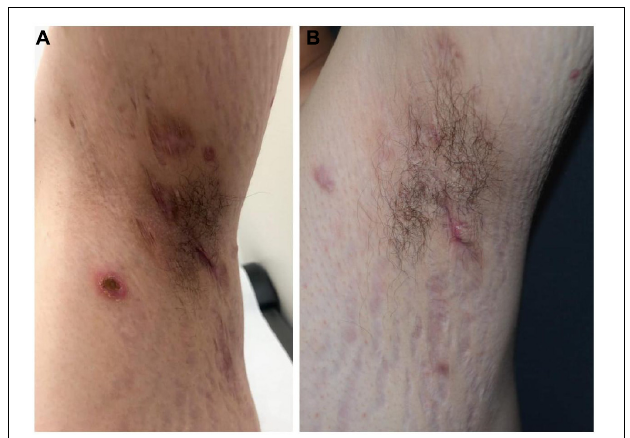
FIGURE 1 | Hidradenitis suppurativa before (A) and following combination therapy (B)